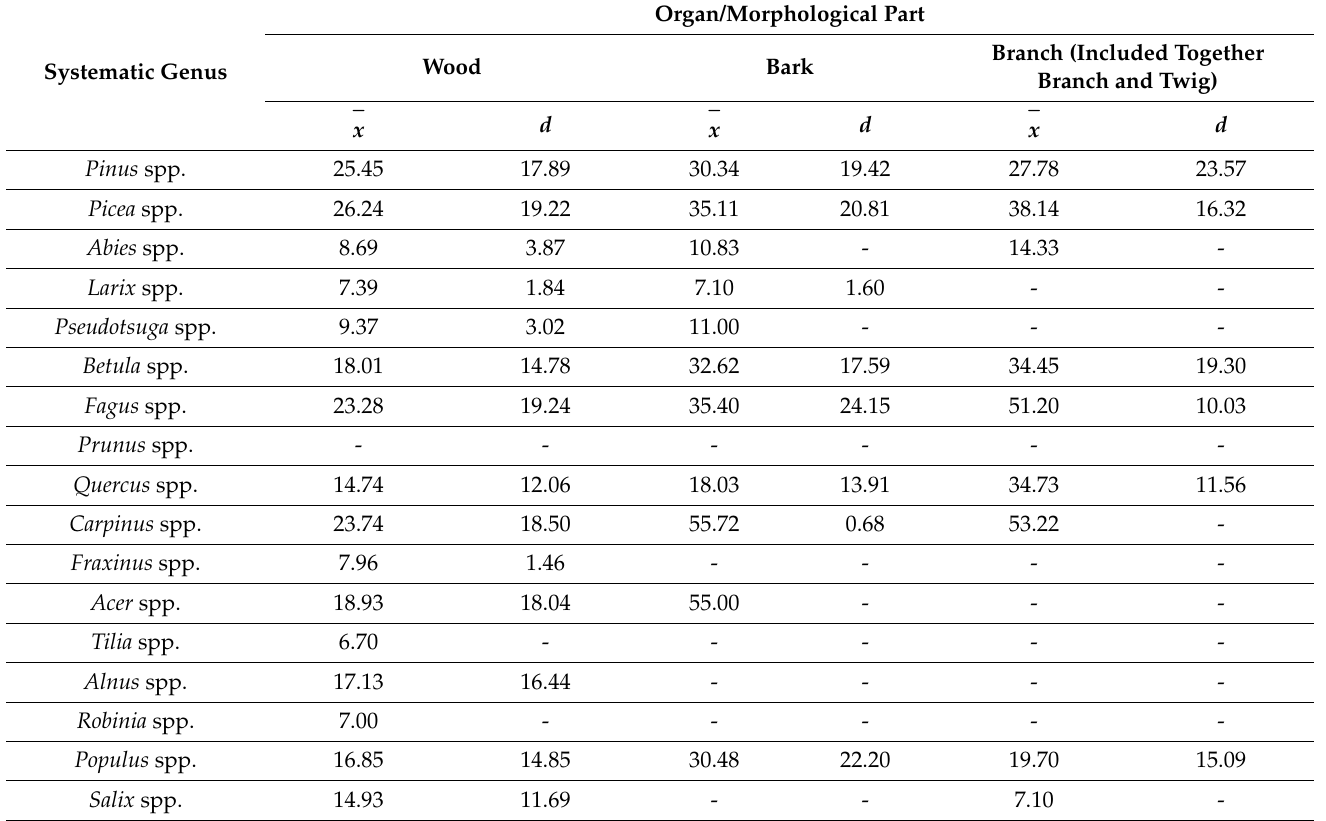
Table A12. Average value and average deviation of the moisture content (%) in various organs of particular systematic genera trees.